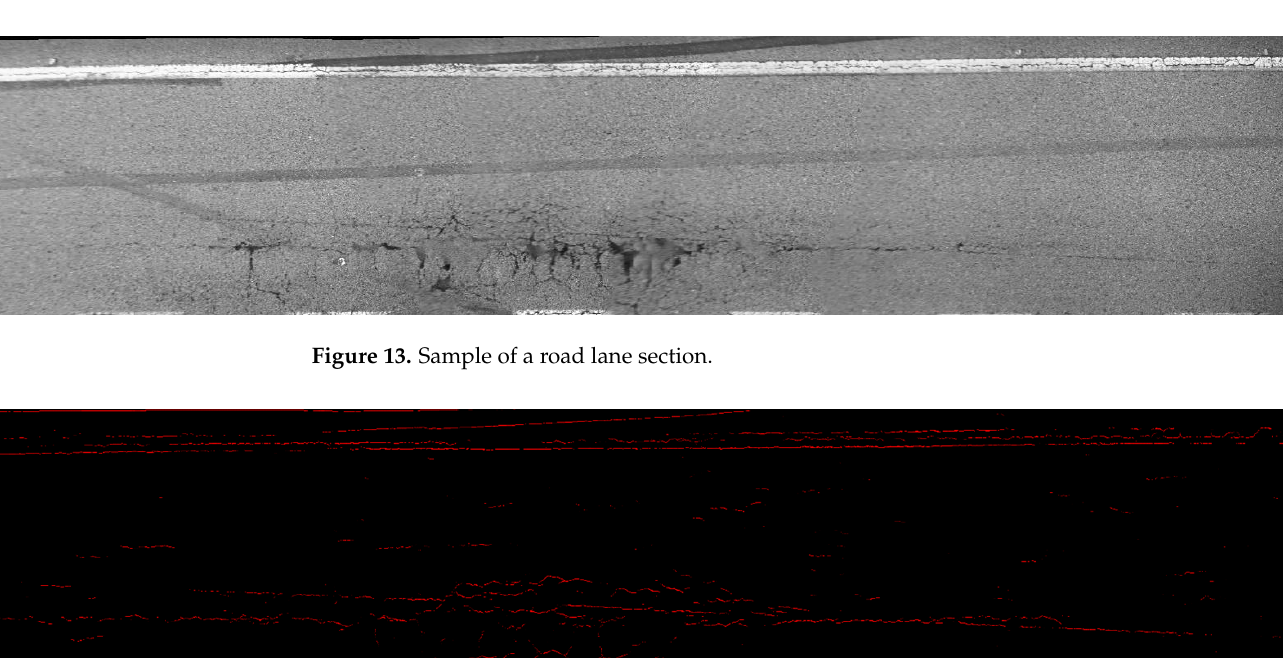
Figure 11. Road lane section processing during the segmentation step.